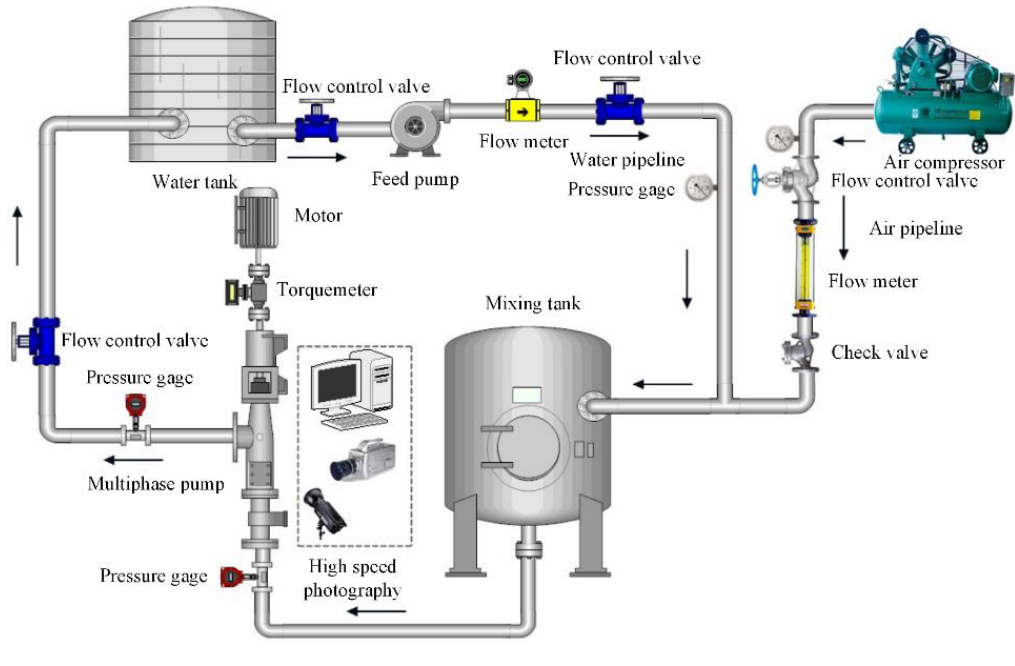
Figure 5. Multiphase pump test system.